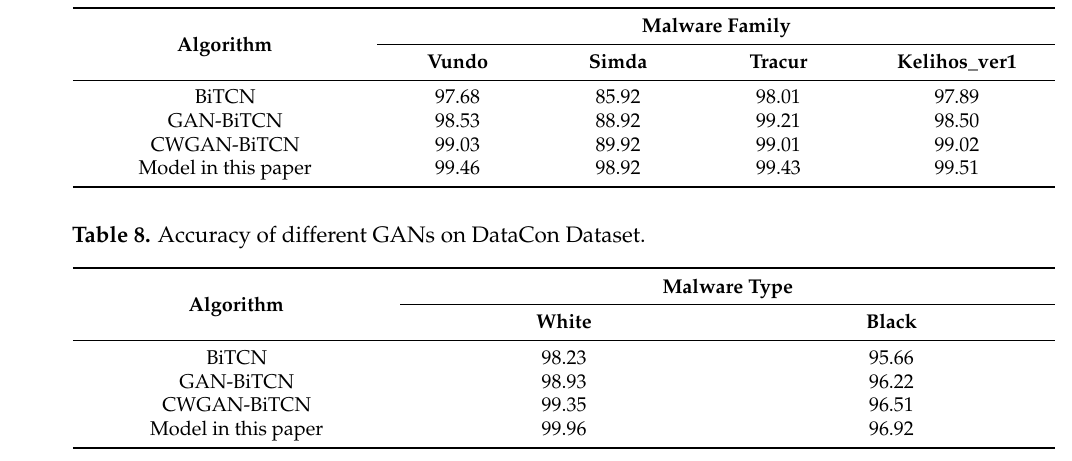
Table 7. Accuracy of different GANs on Kaggle Dataset.